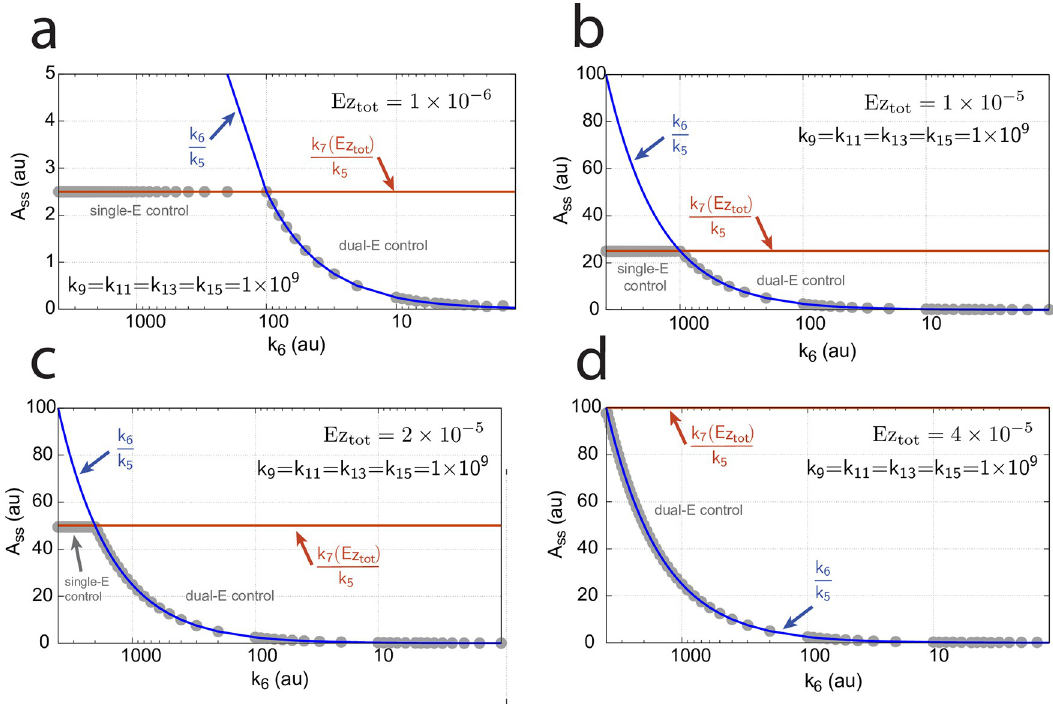
Fig 33. Switching between dual-E and single-E control in the random-order ternary-complex m5 controller at different Ez concentrations. Rate constants are as in Fig 32a with Ez tot values as indicated in the four panels. With increasing Ez tot values (from panel (a) to panel (d)) the operational range of the dual-E controller increases together with increasing set-point values of the single- E controller (Eq 99). Initial concentrations, panel (a): A 0 =2.0, E 1,0 =5.49 × 10 − 2 , E 2,0 =5.21 × 10 3 , Ez 0 =7.4 × 10 − 14